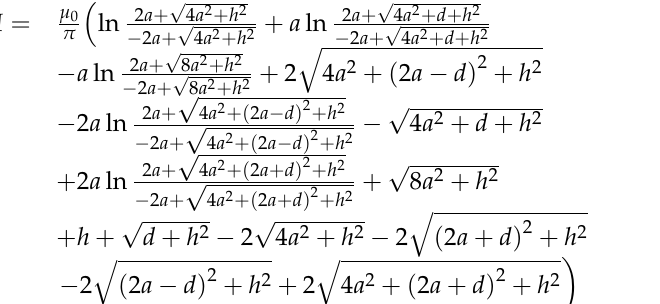
Figure 2. Spatial distribution of coupling coils. ( a ) Coaxial opposite side. ( b ) Coaxial same side. ( c ) Different axis same side. ( d ) Different axis coplanar.